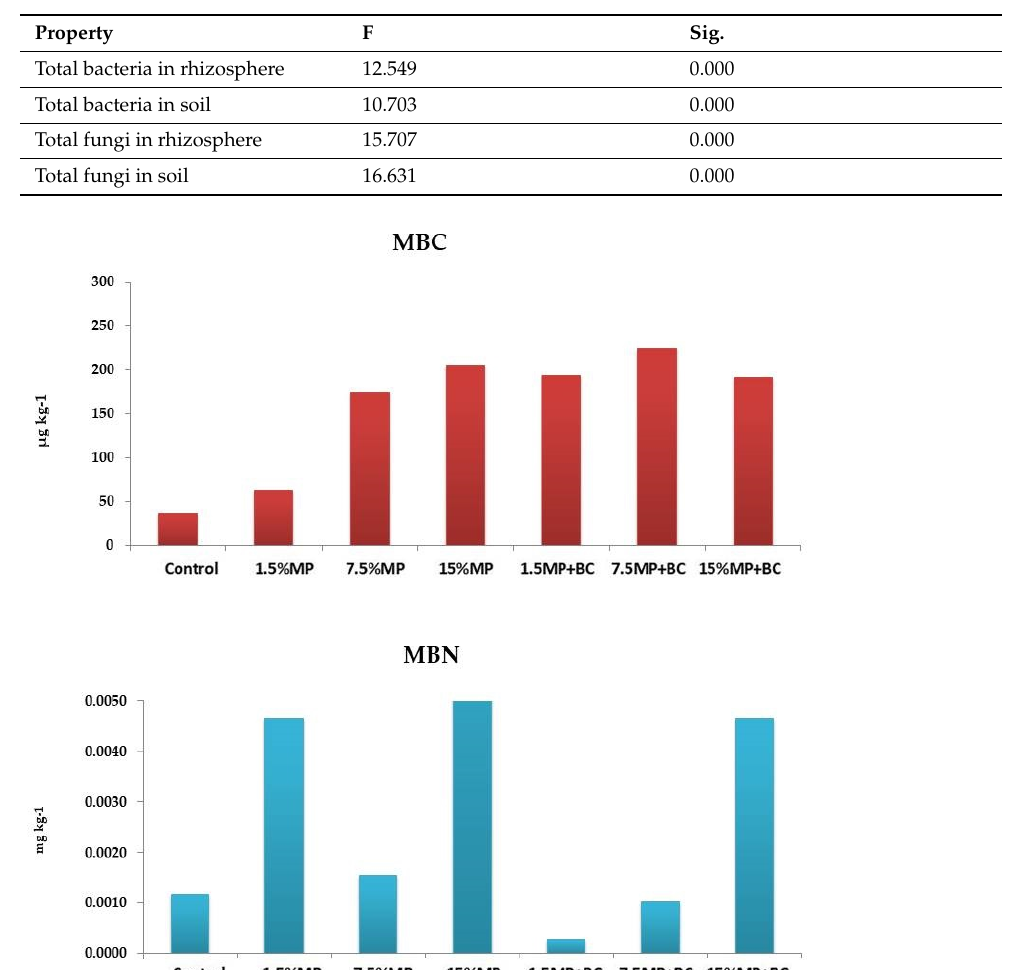
Table 10. One way analysis of variance of total count of bacteria and fungi in rhizosphere and soil affected by biochar after microplastic addition to soil.